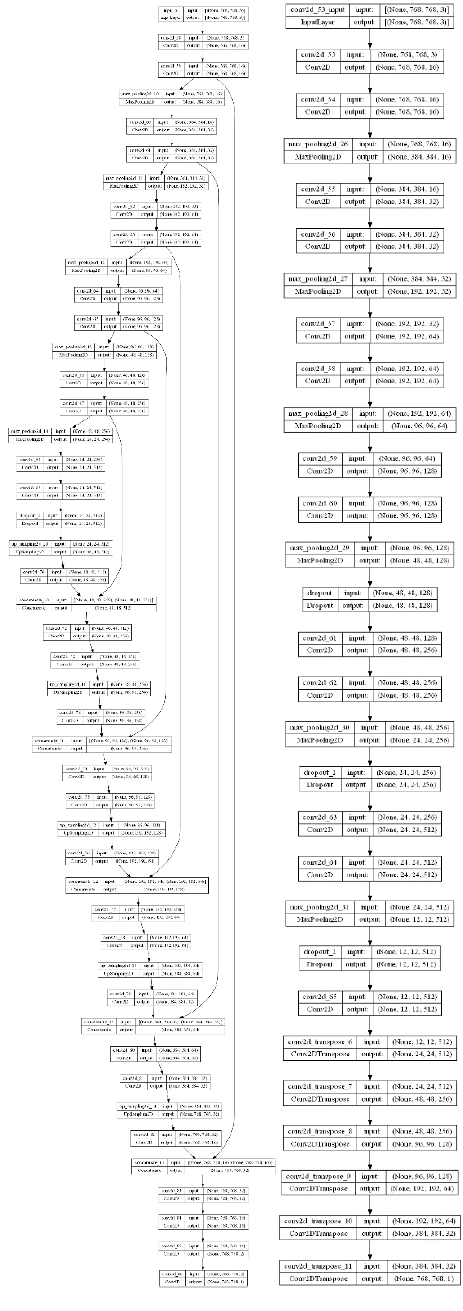
Figure 8. Left sketch of the U-net model with Deepest 4, right sketch of the SegNet model (the images are available with higher resolution at the links in [44,45]).